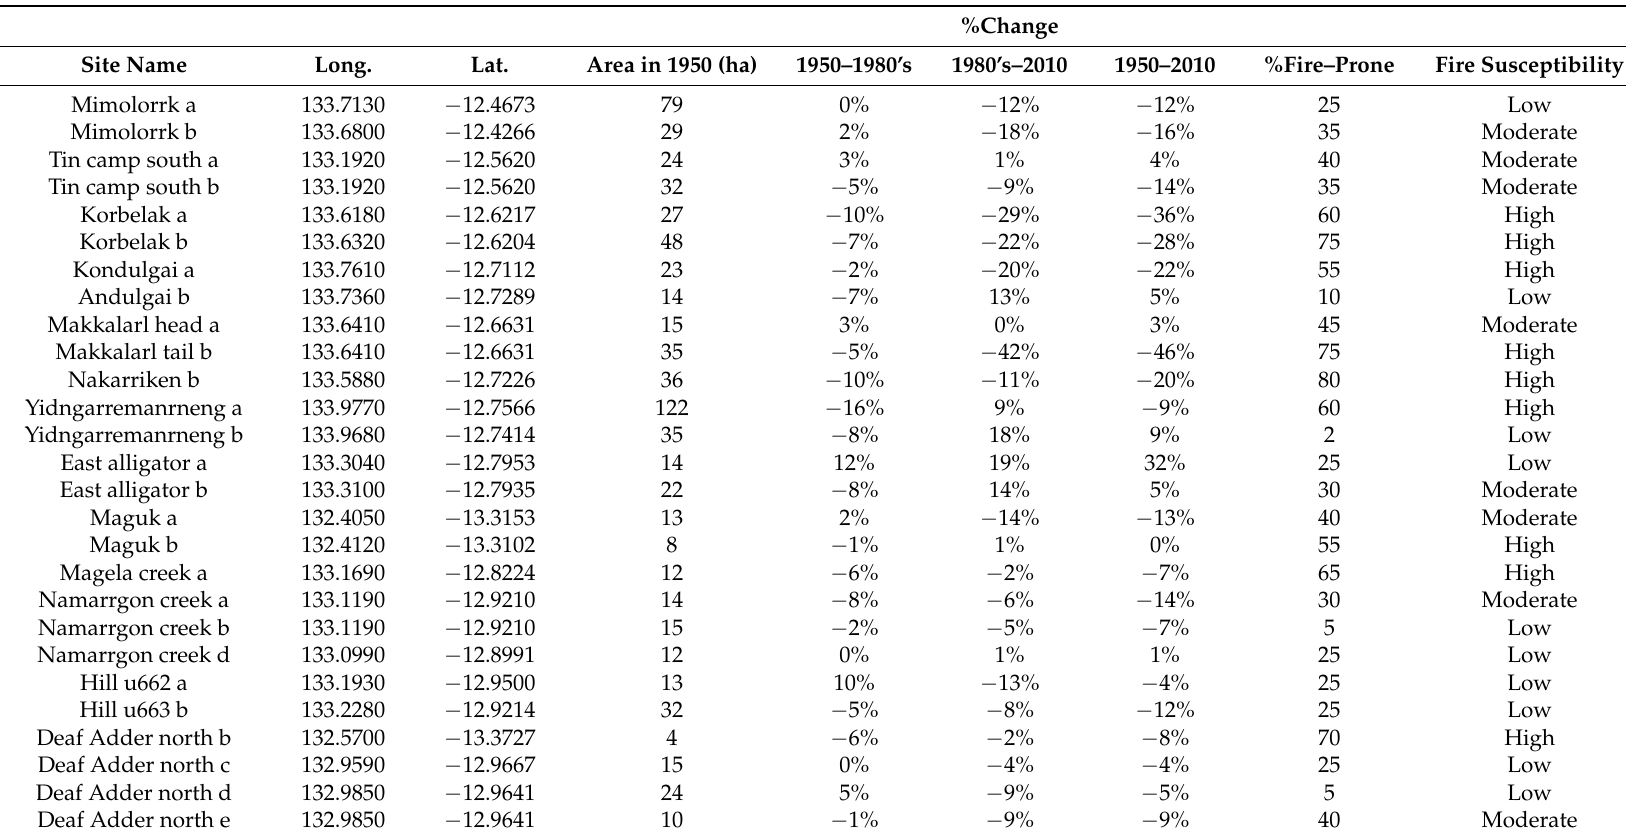
Table A1. The 40 individual Allosyncarpia ternata sites describing: the position (longitude and latitude) of the centroid of the patch; the initial patch area in 1950; the change in the patch area between the three assessment periods (1950–1980, 1980–2010 and 1950–2010); the proportion of the patch perimeter surrounded by fire-prone vegetation; and the categorical fire susceptibility based on the proportion of surrounding fire-prone vegetation and the topographic position of the